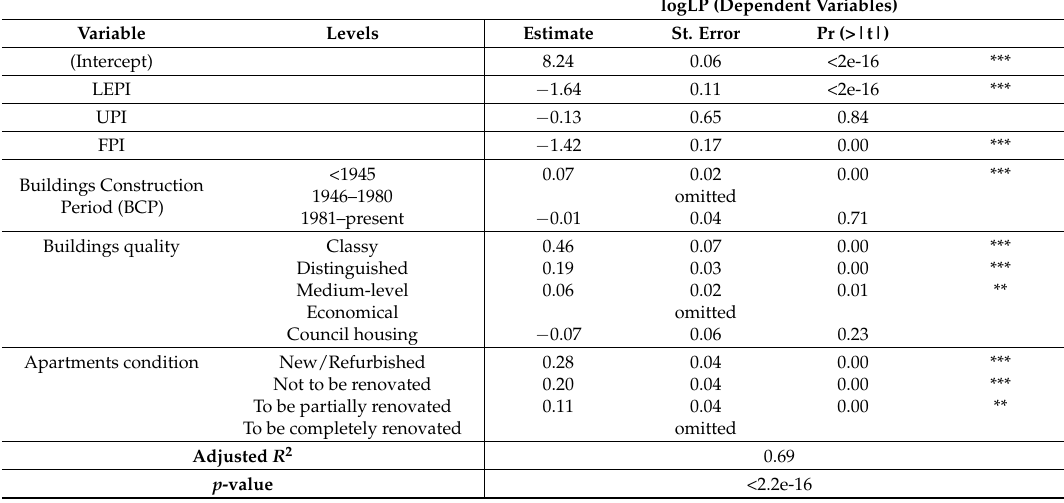
Table 3. Hedonic regression results. The explanatory power of the three indicators and the key categorical variables (physical characteristics). Dependent variable: logLP, measured in Euro per square meter (Source: Authors’ elaboration on TREMO